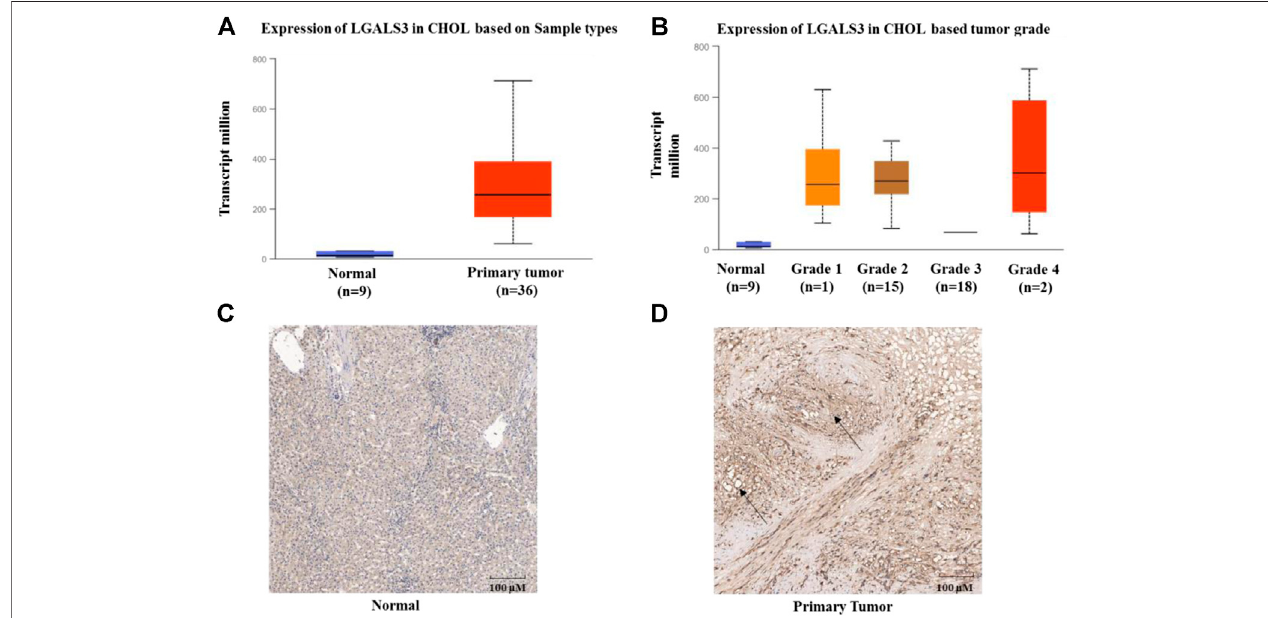
FIGURE 1 | Expression of Gal-3 in ICC (A) Expression of Gal-3 based on sample types (B) Expression of Gal-3 based on cancer stages (C) Expression of Gal-3 in paracancerous tissues (D) Expression of Gal-3 in ICC tissues. UALCAN was used to analyze TCGA data of cholangiocarcinoma in Figures 1A,B . Y -axis denotes the expression level of gene of interest, while X -axis denotes groups of control (Normal, nine samples) and patients (36 samples). Staining of Gal-3 in Figure 1D was highlighted by black arrows.